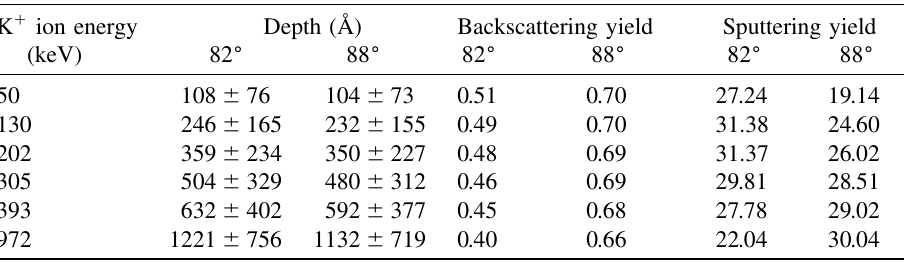
TABLE I. TRIM 2003 simulation of K (cid:1) ion hitting stainless steel at different energies and angles from